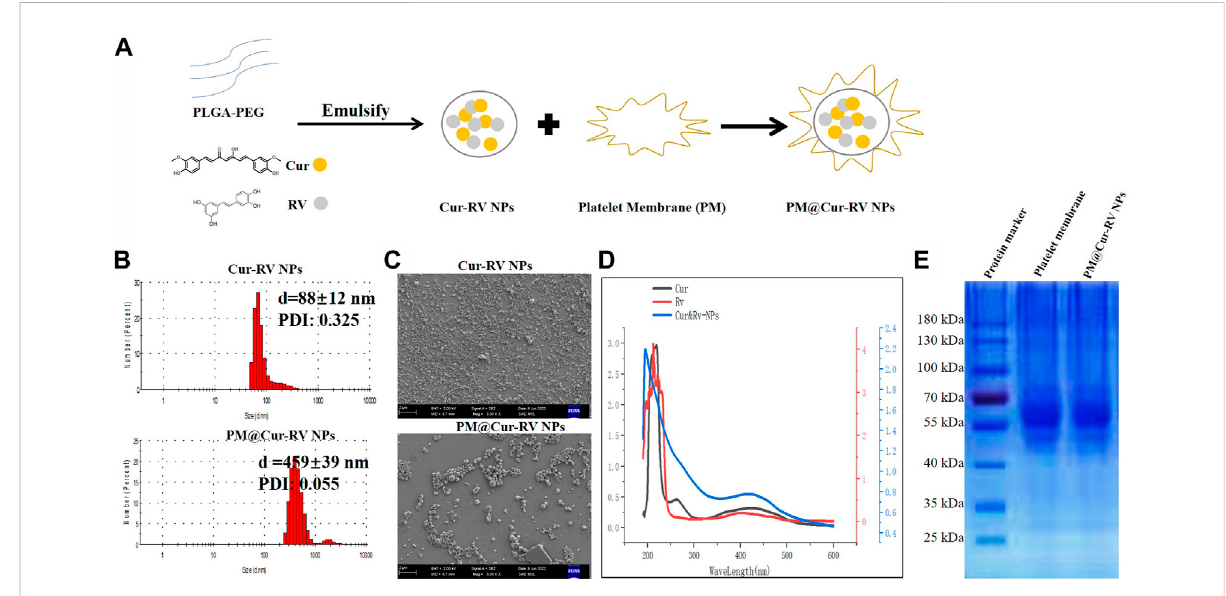
FIGURE 1 CharacterizationofCurandRV-coloadedPLGAnanoparticles. (A) SchemeillustratesthepreparationofCur-RVNPsandPM@Cur-RVNPsusing emulsi fi cationmethod. (B) SizedistributionofCur-RVNPsandPM@Cur-RVNPs,respectively. (C) RepresentativemorphologyphotosofCur-RVNPs andPM@Cur-RVNPsimagedbyscanningelectronmicroscope(1bar=2 μ m). (D) UV-visspectrumoffreeCur,RVandCur-RVNPsindicatedthatCur and RV were both successfully encapsulated in Cur-RV NPs, which shown by the similar absorption peaks at around 210 nm. (E) SDS-PAGE protein analysis of platelet membrane (PM), and PM@Cur-RV NPs (the samples were determined at same protein